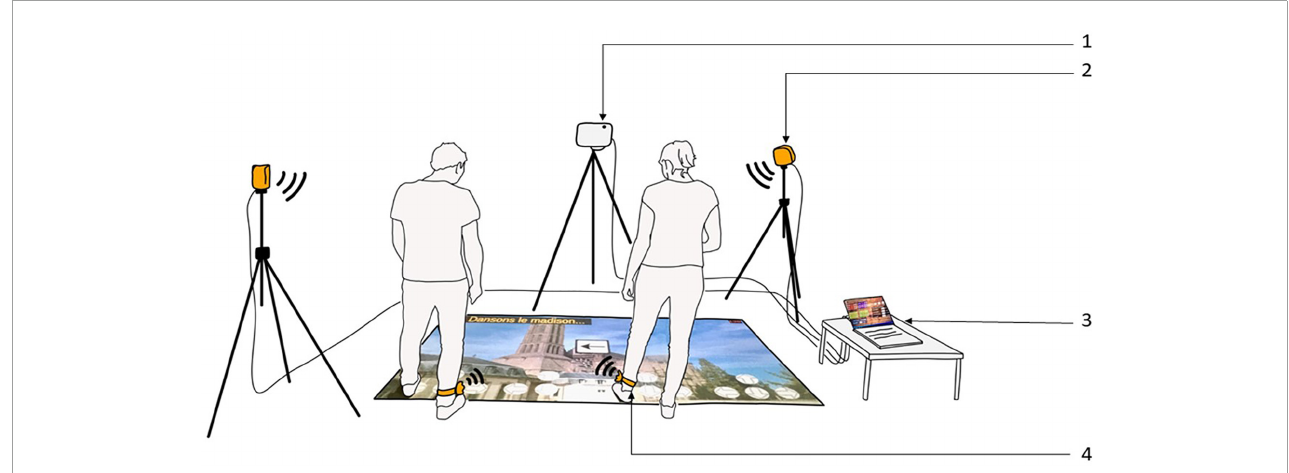
FIGURE1 The exergame. (1) Video projector, (2) HTC vive infrared camera, (3) computer, and (4) HTC vive infrared tracker. In this illustration, only two participants are represented, the objective being to maximize